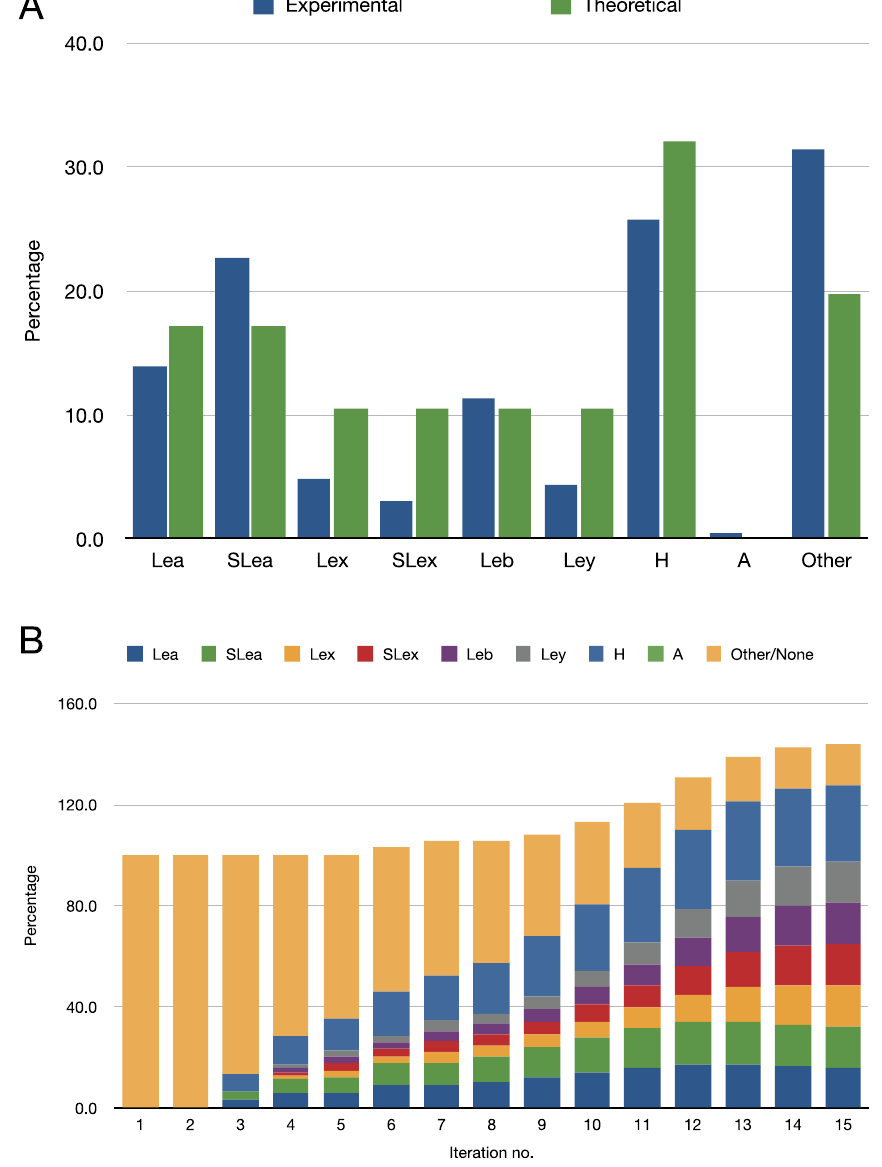
Figure 7. Numbers of epitopes appearing in HMO populations, real and simulated, expressed as a percentage of the total number of structures. ( A ) Percentages of the total numbers of each epitope in the experimental ( N = 226) and simulated ( N = 51,982; i = 13) HMO populations. As a result of multi-antennarity (branching), more than one epitope can be present on a single HMO. ( B ) Percentages of epitopes appearing in simulations, to which a limit of four GlcNAc residues per HMO was applied, as a function of iteration number ( i